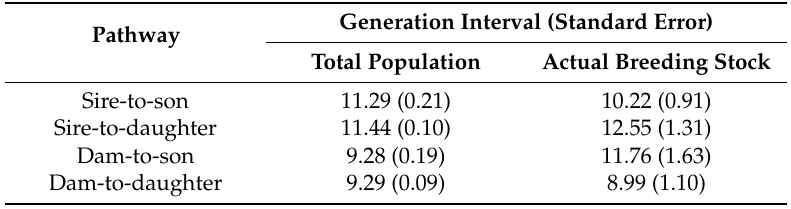
Table 2. Descriptive statistics of the generation intervals in years.